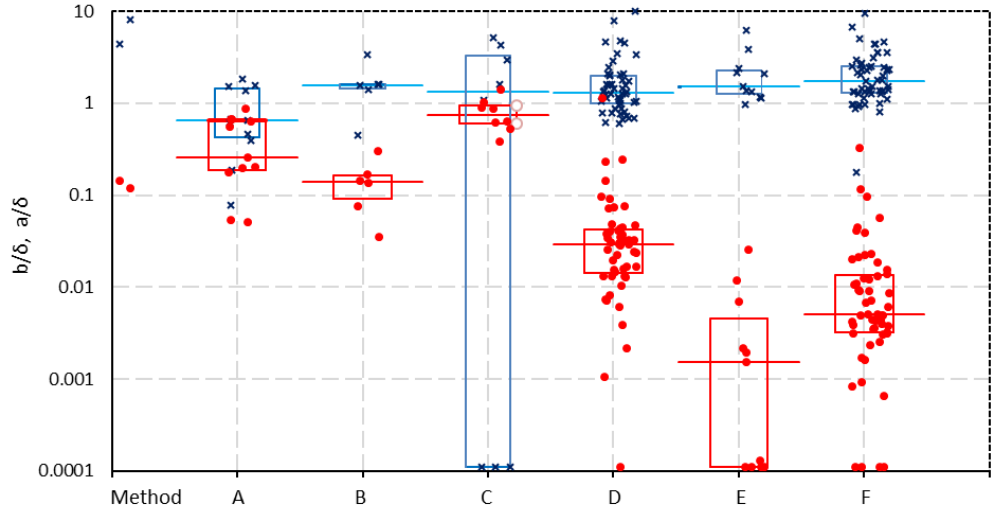
Figure 6. Values of parameters a/δ (blue crosses) and b/δ (red dots) specified for the different measuring methods (A, B... F). The parameters a and b are divided by the membrane thickness δ to express the material properties of the membrane material. To prevent overlap of the data points, X-values are slightly offset on the X-axis. Values below 0.0001 or above 10 are offset to the borders of the graph. The horizontal lines indicate the median value for each data cluster, while the boxes indicate the lower and upper quartiles.